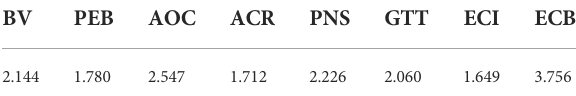
TABLE 1 Full collinearity